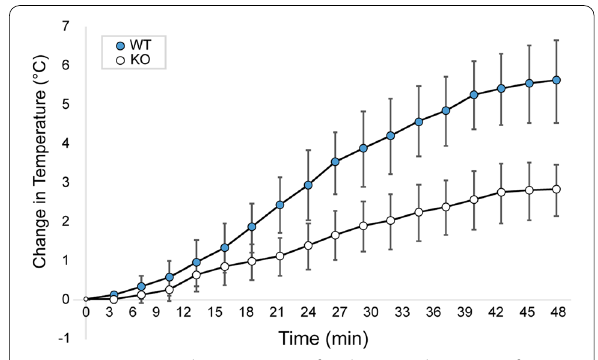
Fig. 2 Average rectal temperature of male WT and KO mice after NE injection during [ 18 F]FDG uptake for Set 2. To further corroborate the difference in BAT thermogenic capacity of our WT (blue) and KO (white) mice, rectal temperature was also recorded during the [ 18 F] FDG uptake in the second set of experiments. Here, by studying mice of similar size, and by carefully controlling both NE dose and room temperature conditions, we were able to detect a significant ( p < 0.001) difference in the increase in rectal temperature between WT and KO mice. Error bars represent the standard deviation at each time